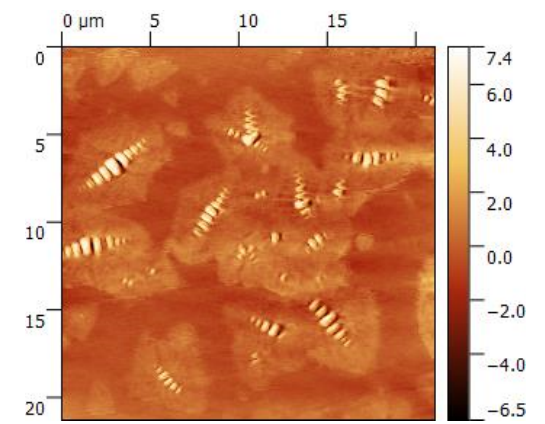
Figure 1. Typical AFM phase contrast picture of well developed micrustructures within a bitumen binder showing the peri (bee) and perpetua phase and cystalline features of the peri phase [5]